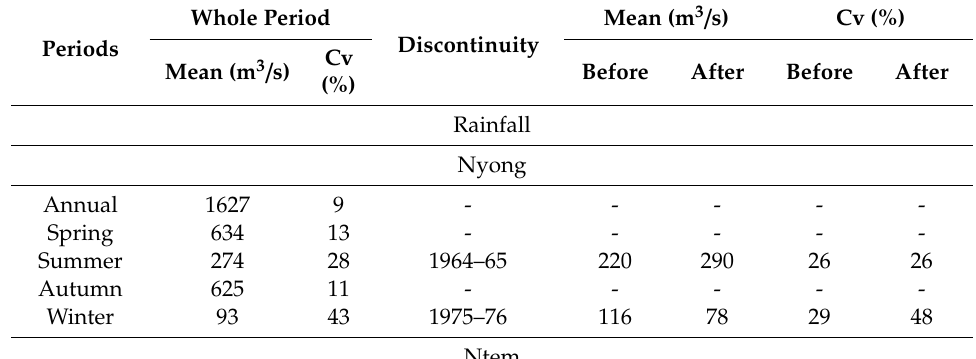
Figure 1. Location map of Nyong and Ntem watersheds. Table 1. Statistics relating to the evolution of precipitation and average discharges at annual and seasonal time steps over the study period, but also before and after the discontinuity. Cv: coe ffi cient of